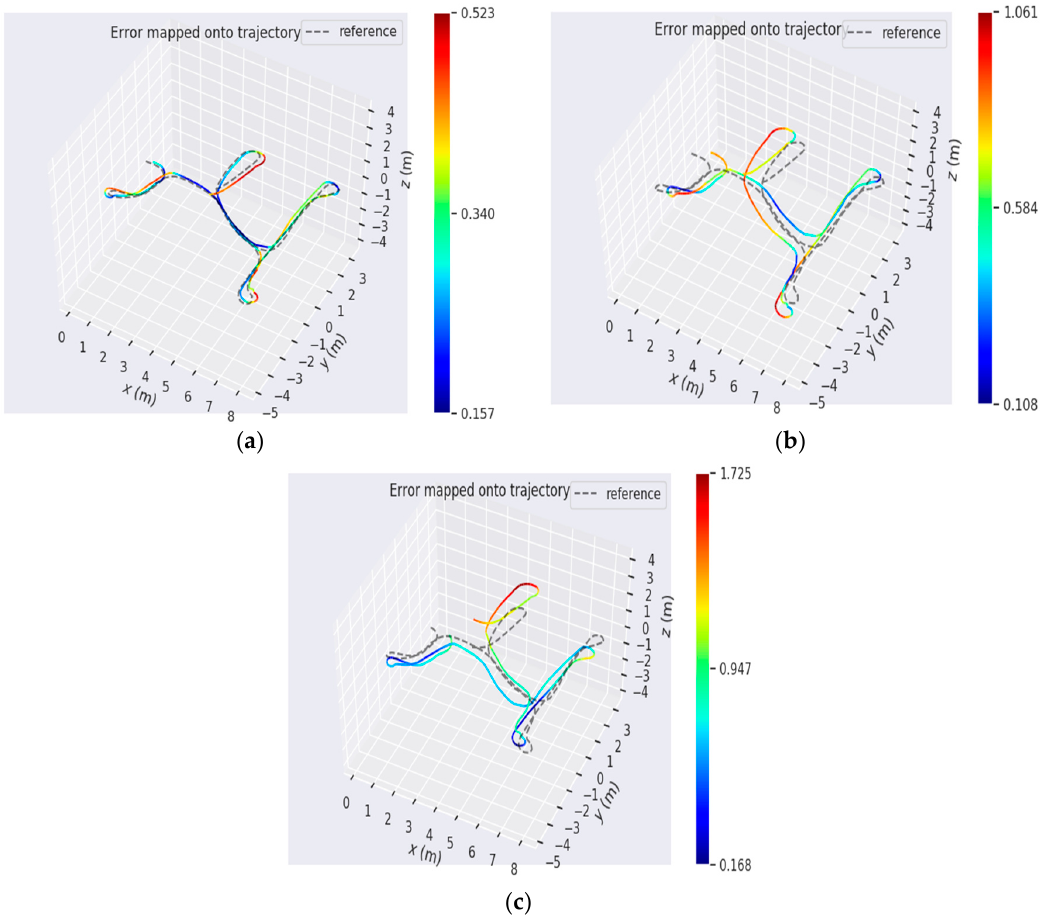
Figure 11. The comparative absolute translation errors. The trajectory heat map estimated by ( a ) our system, ( b ) PLVIO, and ( c ) VINS-MONO in